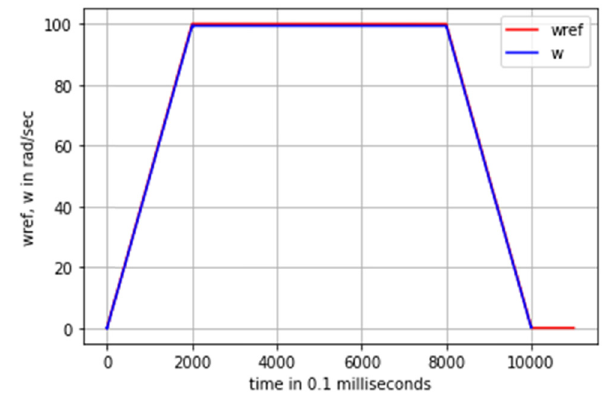
Figure 7: Response of PID control system for free running DC motor.